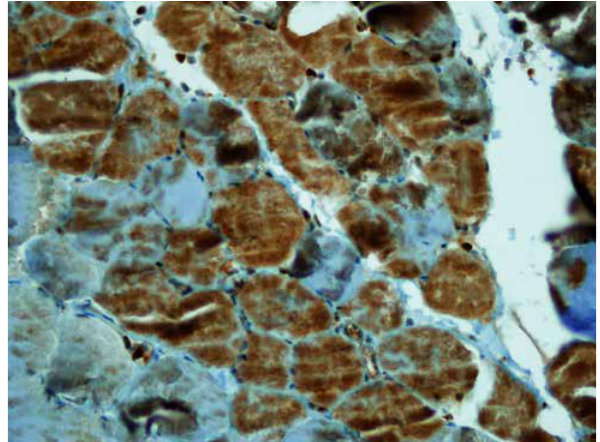
Figure 3. iNOS staing of IR was very